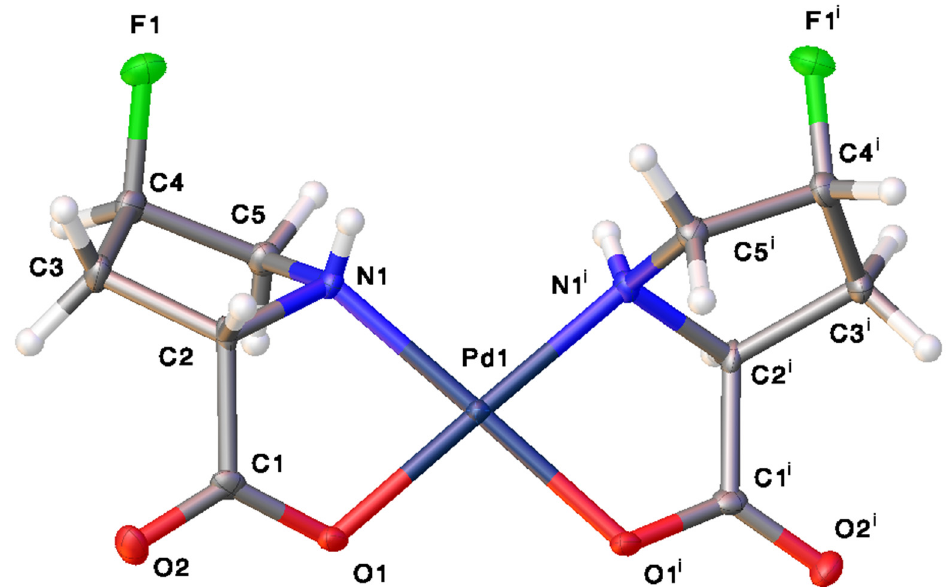
Figure 8. Cis -bis-( trans -4-fluoroprolinato)palladium(II), ( 4 ). Thermal ellipsoids are drawn at the 50% probability level. Atoms labeled with superscript “I” are generated by a C 2 rotation. CCDC:1913621.